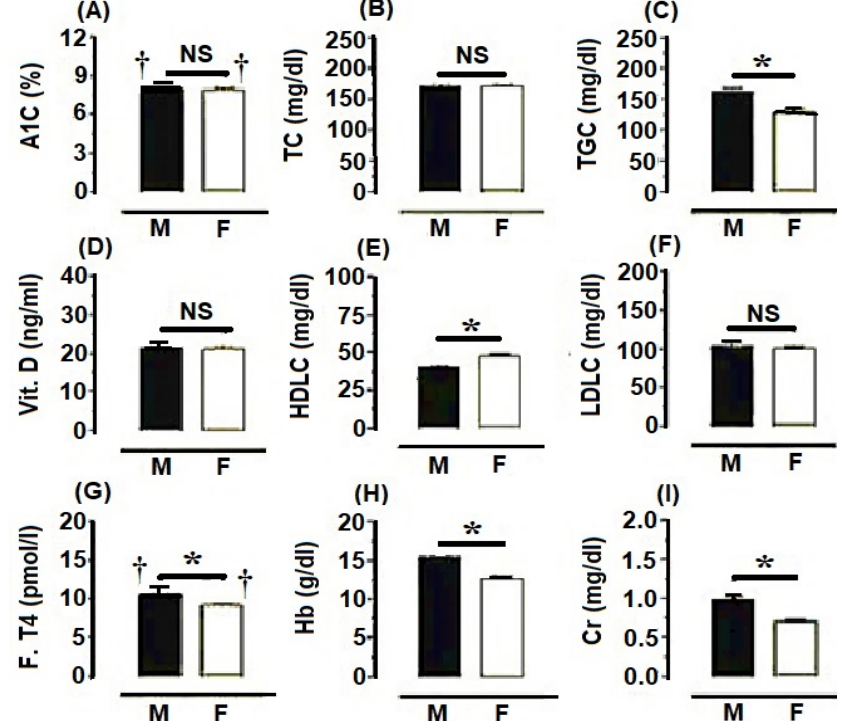
Figure 1. Characteristics of metabolic profiles in both male (M) and female (F) participants of the general population in Asir, South KSA. All data were expressed as mean ± SEM. Asterisk (*) denotes significant difference ( p < 0.05) between males and females. The sign (†) denotes risky concentration level of the parameter. NS denotes a nonsignificant difference. Other explanations were given in Table 1.